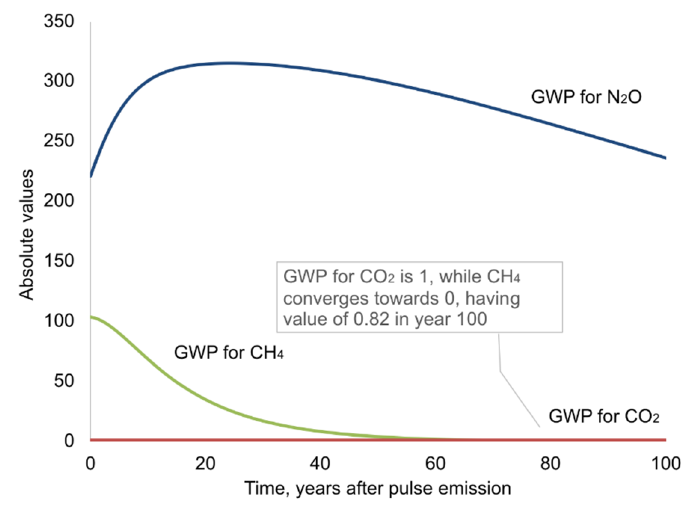
Figure 4. Normalized GWP values as a response to emission of CO 2 , N 2 O, and CH 4 at year zero. The values are normalized to the maximum value of the corresponding GWP of each gas, unitless.